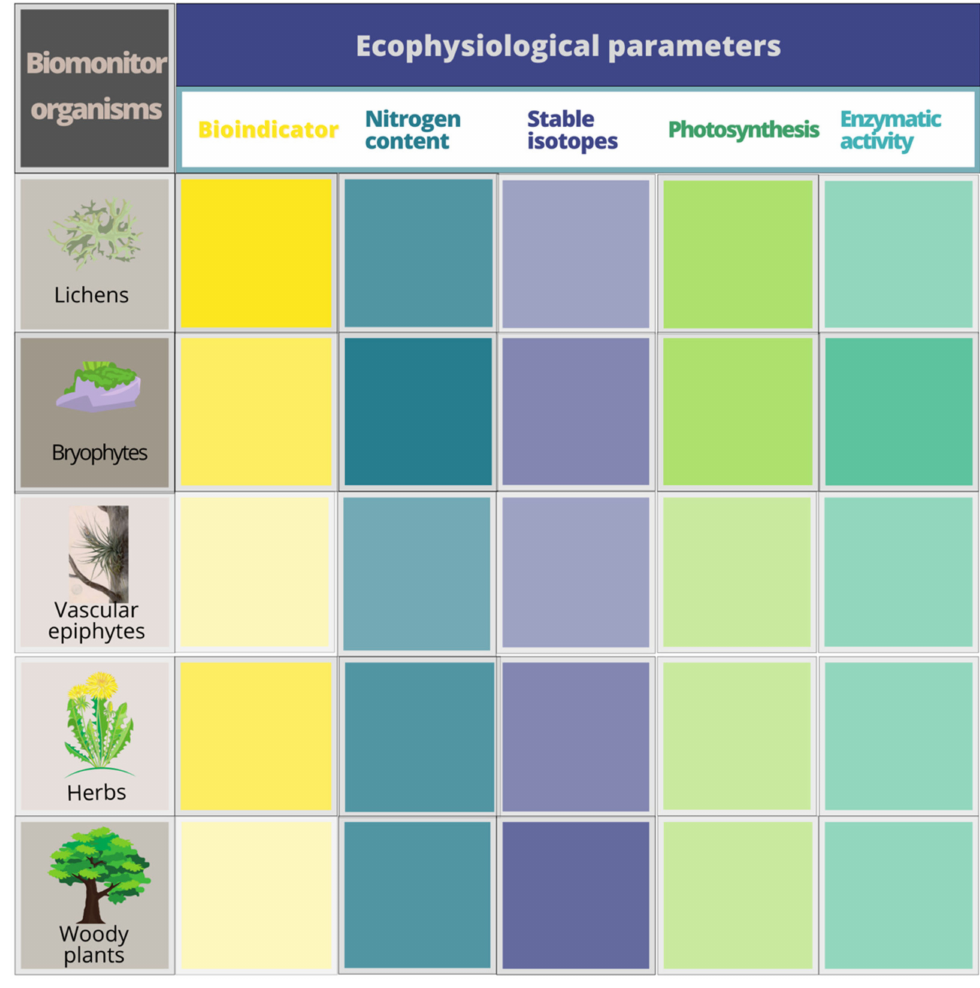
Figure 2. Commonly utilized biomonitoring organisms and ecophysiological parameters that are responsive to the rate and type of atmospheric nitrogen deposition. The intensity of the cell color for biomonitor and parameter intersections is indicative of its relative frequency based on a review of the academic literature. See underlying studies in the Supplementary